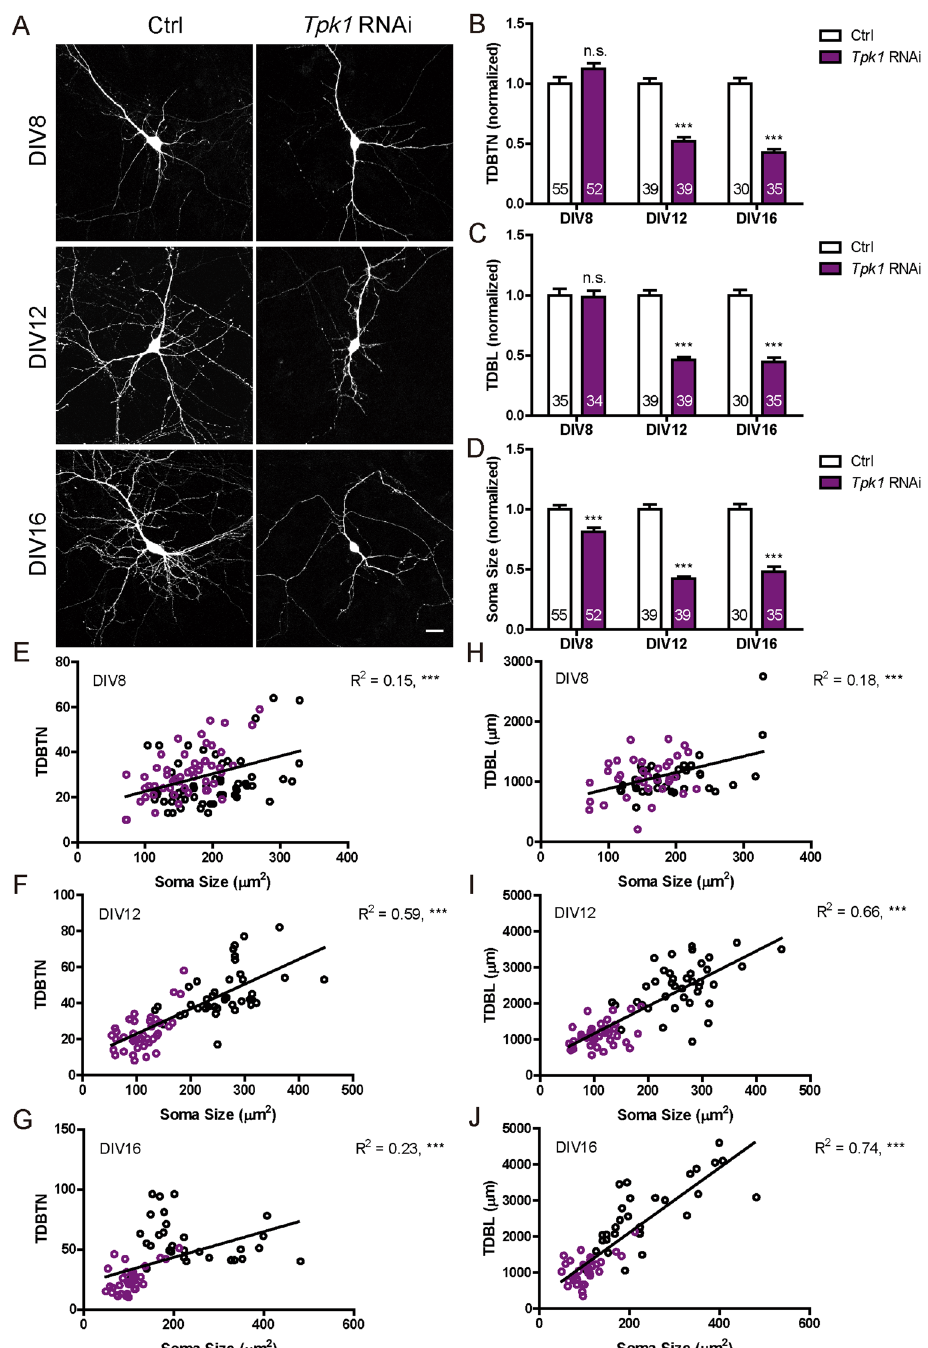
Figure 1. Tpk1 knockdown in primary hippocampal neurons significantly reduced TDBTN, TDBL and soma size. ( A ) Representative images of primary hippocampal neurons transfected with control and Tpk1 RNAi constructs, fixed at DIV8, DIV12 or DIV16. Scale bar: 20 μ m. ( B ) Quantitation of TDBTN: Tpk1 RNAi at DIV8 (1.12 ± 0.05, n.s.), DIV12 (0.52 ± 0.04, P < 0.001), DIV16 (0.43 ± 0.03, P < 0.001). ( C ) Quantitation of TDBL: Tpk1 RNAi at DIV8 (0.99 ± 0.05, n.s.), DIV12 (0.46 ± 0.02, P < 0.001), DIV16 (0.45 ± 0.03, P < 0.001). ( D ) Quantitation of soma size: Tpk1 RNAi at DIV8 (0.81 ± 0.03, P < 0.001), DIV12 (0.42 ± 0.02, P < 0.001), DIV16 (0.48 ± 0.04, P < 0.001). ( B – D ) Two way ANOVA followed by Bonferroni’s post-test. ( E – G ) Significant correlations exist between TDBTN and soma size at DIV8 ( E , n = 107, R 2 = 0.15, P < 0. 001), DIV12 ( F , n = 78, R 2 = 0.59, P < 0. 001) and DIV16 ( G , n = 65, R 2 = 0.23, p < 0. 001). ( H – J ) Significant correlations are observed between TDBL and soma size at DIV8 ( H , n = 69, R 2 = 0.18, P < 0.001), DIV12 ( I , n = 78, R 2 = 0.66, P < 0.001) and DIV16 ( J , n = 65, R 2 = 0.74, P < 0.001). In ( E – J ) Black circles represent control neurons, while purple circles represent Tpk1 RNAi neurons. In this and all subsequent figures, “ n ” represents the number of neurons and is as indicated inside bar graphs, error bars represent s.e.m.; * P < 0.05, ** P < 0.01, *** P < 0.001, n.s. P >